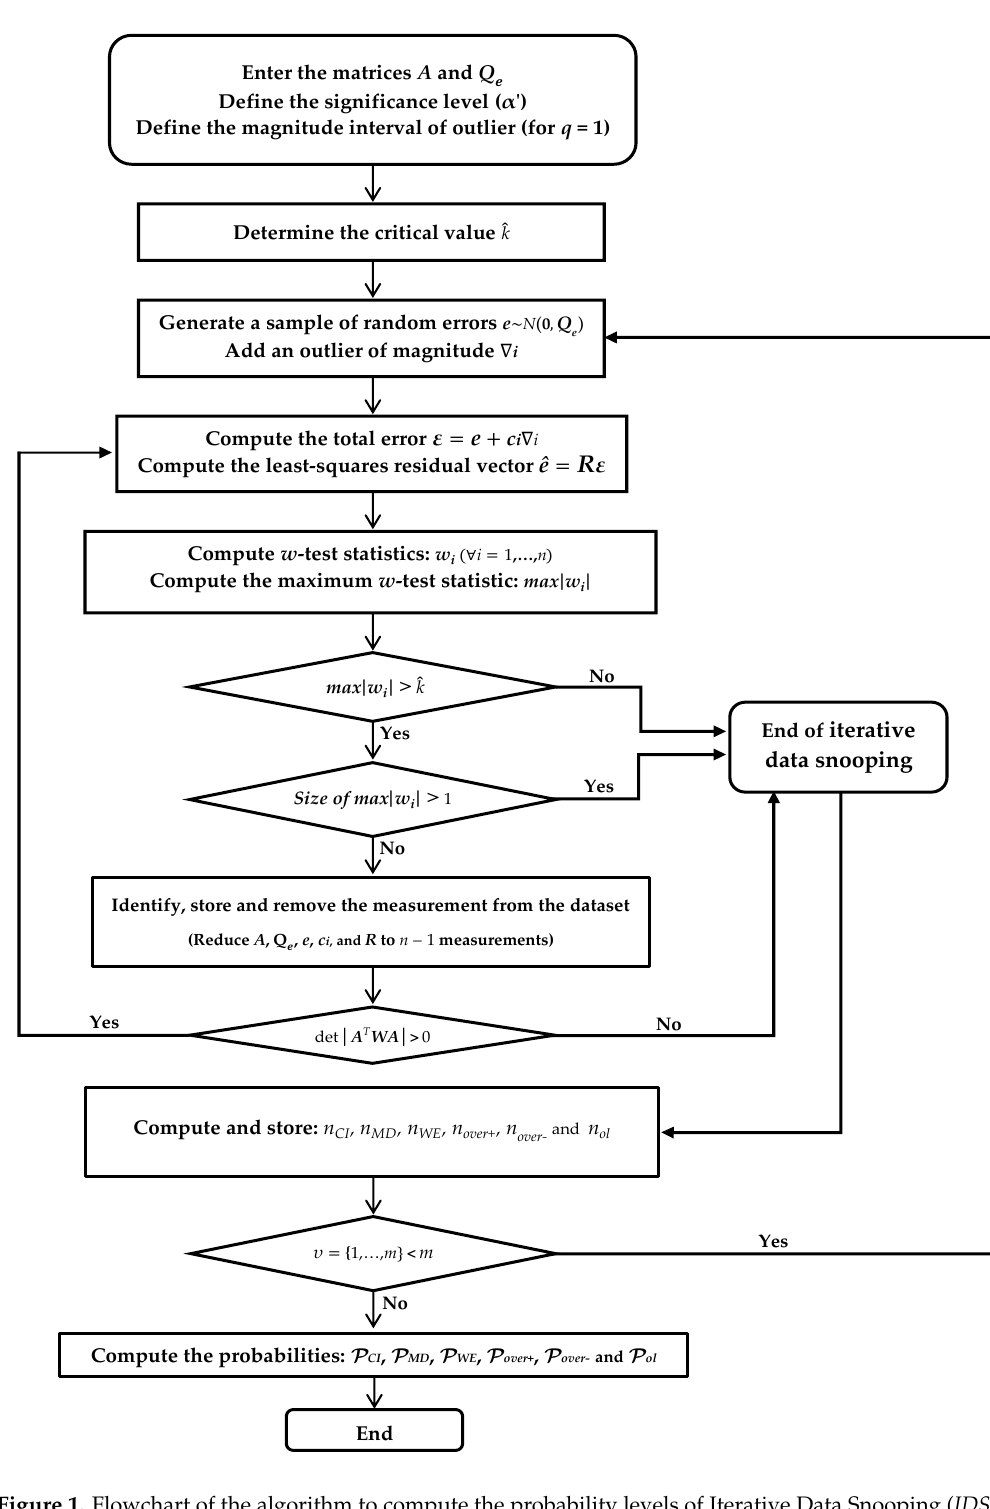
Figure 1. Flowchart of the algorithm to compute the probability levels of Iterative Data Snooping ( IDS ) for each measurement in the presence of an